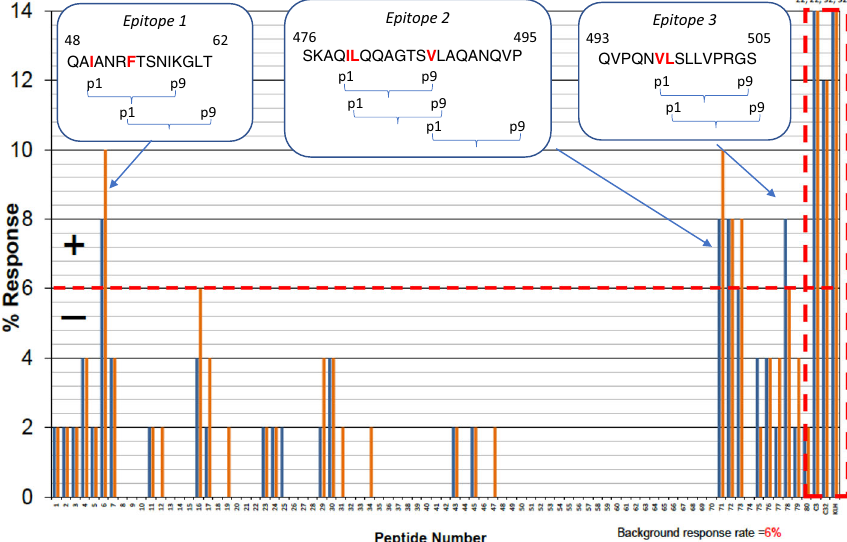
Fig. 4 Mapping of T-cell epitopes in entolimod. Non-adjusted (blue bars) and adjusted (orange bars) proliferation assay data for 80 test peptides (numbered 1 – 80) spanning the sequence of entolimod derivative 33MX and the highly immunogenic control peptides C3, C32, and KLH (dashed box at right end of graph) over a panel of PBMC samples from 50 healthy donors. Peptides inducing positive (SI ≥ 2.00, P < 0.05) T-cell proliferation responses at a frequency above the background response threshold (6%, red dotted line) contain major T-cell epitopes. Peptides spanning identi fi ed Epitopes 1 – 3 and their positions in the 33MX sequence are shown in boxes. Predicted anchor residues (p1) are shown in bold red font. See Supplementary Methods, Abzena Report 1 for additional